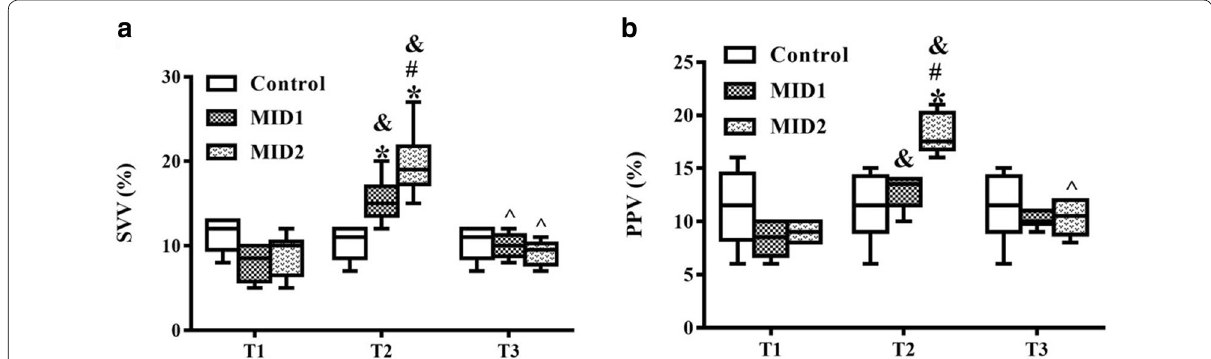
Fig. 2 Midazolam increased preload dependency of endotoxic shock rabbits. a The effects of midazolam on pulse pressure variation between the Control, MID1 and MID2 groups at T1, T2 and T3. b The effects of midazolam on stroke volume variation between the Control, MID1 and MID2 groups at T1, T2 and T3. PPV pulse pressure variation, SVV stroke volume variation; * p < 0.05 versus Control, # p < 0.05 versus MID1, & p < 0.05 versus T1, ^ p < 0.05 versus T2, n =